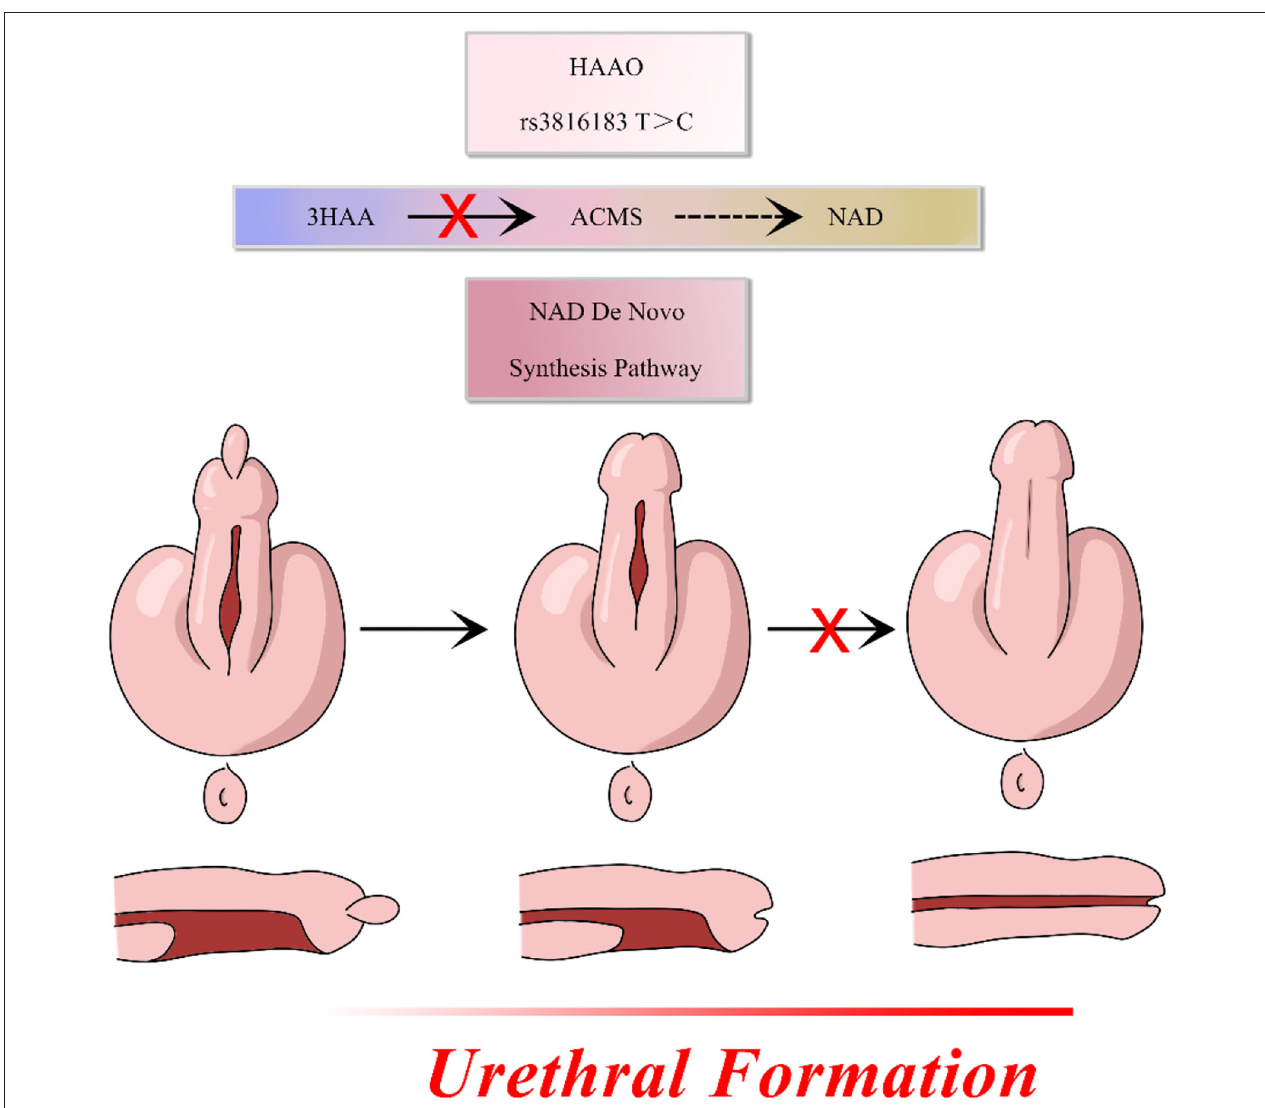
FIGURE 1 | HAAO rs3816183 T > C polymorphism may disrupt the metabolism of its encoded protein leading to disorders of NAD synthesis, which contribute to the pathogenesis of hypospadias.